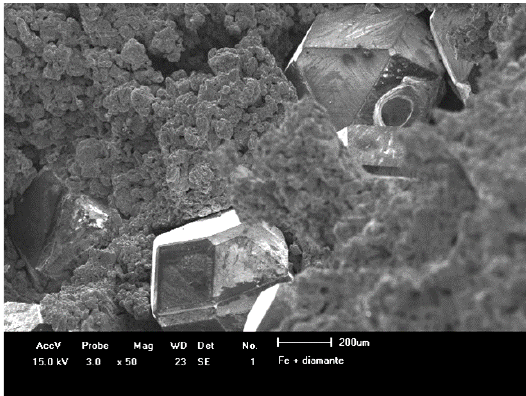
) and yield strength (σ ) of diamond Figure 9. Micrograph of uncoated Fe-diamond composite after r y compression test.